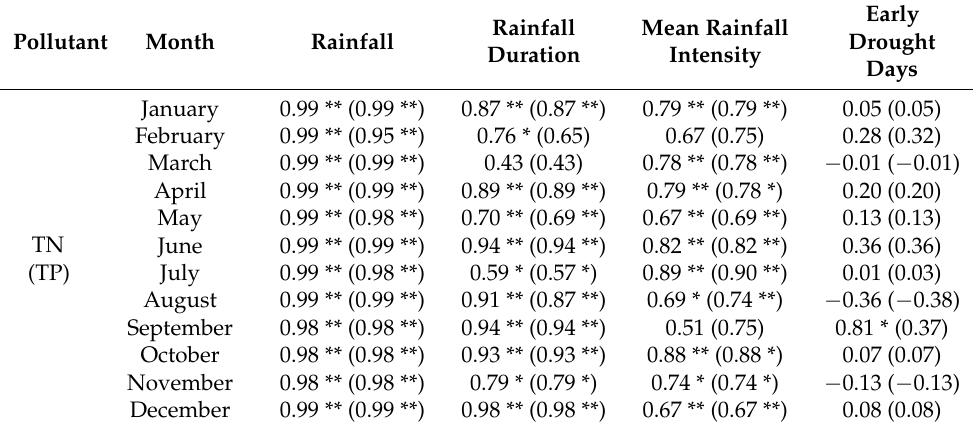
Table 5. Correlation analysis of pollution load and its influencing